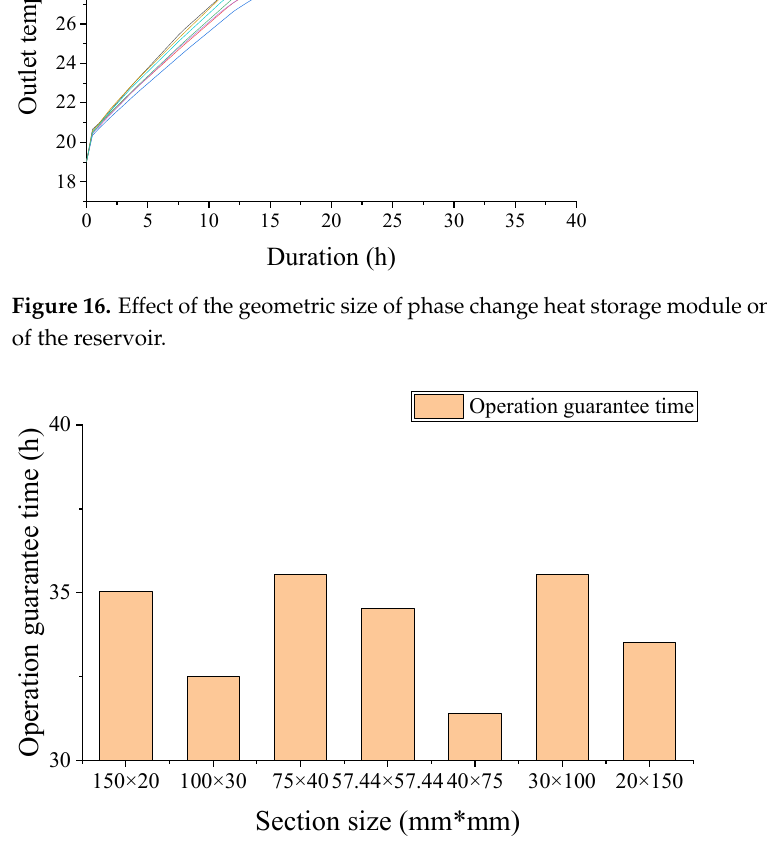
Figure 17. The influence of phase change heat storage module geometry size on the guaranteed operation time of the reservoir.